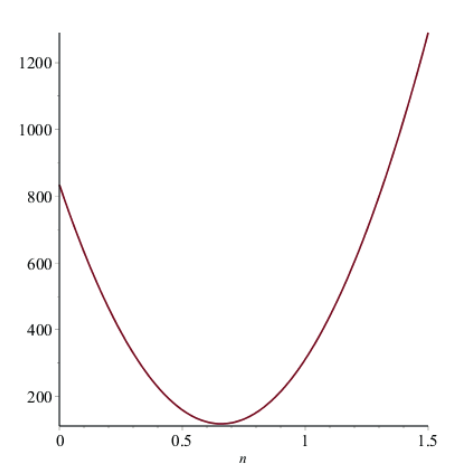
Figure 33: Plot of A ( D